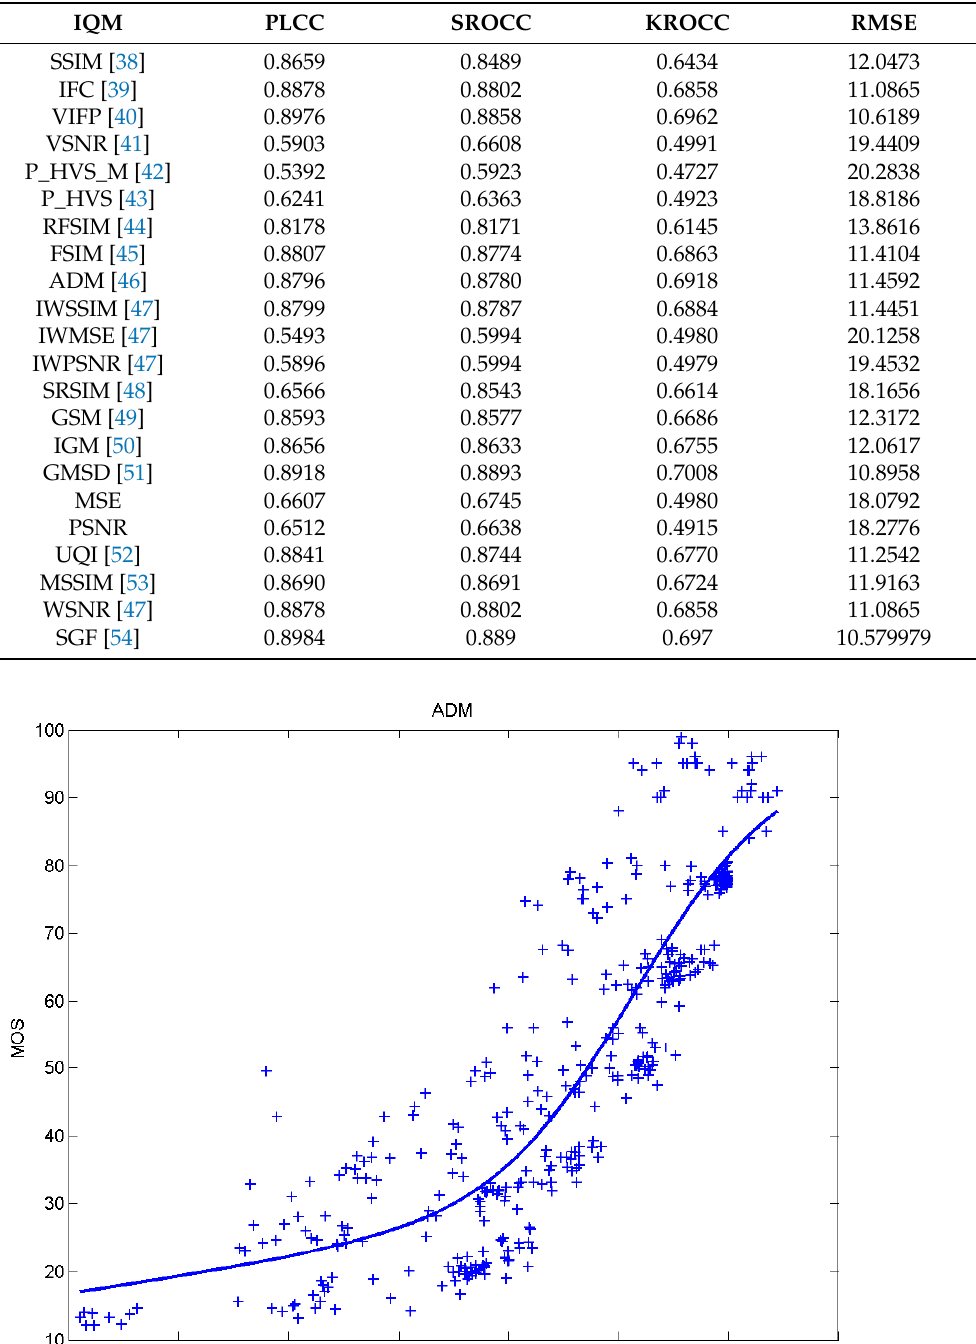
Table 6. Pearson’s linear correlation coefficient (PLCC), Spearman’s rank order correlation coefficient (SROCC), Kendall’s rank order correlation coefficient (KROCC) and root–mean–square error (RMSE) for the various image quality metrics (IQM).